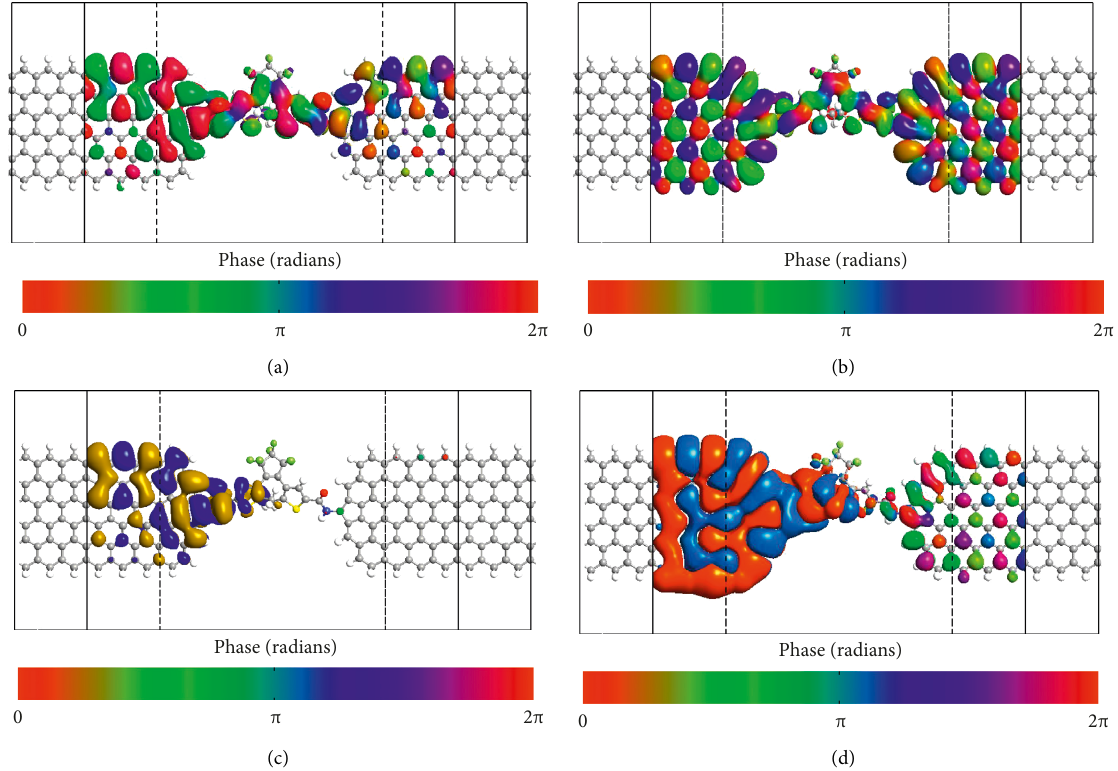
Figure 6: Spin-resolved transmission eigenstates of the thermal spin devices ( R state, eV, (c) open state, eV, and (d) open state, eV. The isovalues are 0.1 ˚A − 3/2